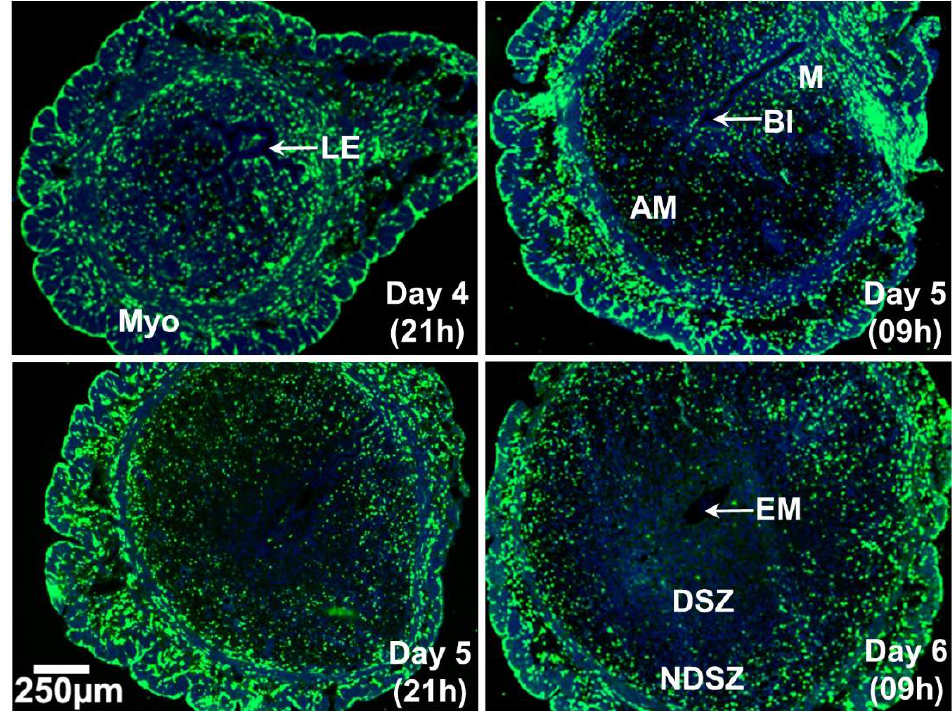
Figure 1. Event-specific change in the distribution pattern of uterine CD45 + immune cells at 12 h intervals during the peri-implantation period (days 4-6) of pregnancy. Cross sections obtained from two pieces of uterine tissues/mouse/timepoint of pregnancy were fixed, immunostained with anti- CD45 (green), counterstained with DAPI (blue) and photographed. At least three pregnant mice were used at each timepoint of pregnancy. AM, anti-mesometrial side; BL, blastocyst; DSZ, decidualized stromal zone; EM, embryo; LE, luminal epithelium; M, mesometrial side, Myo, myometrium; NDSZ, non-decidualized stromal zone.